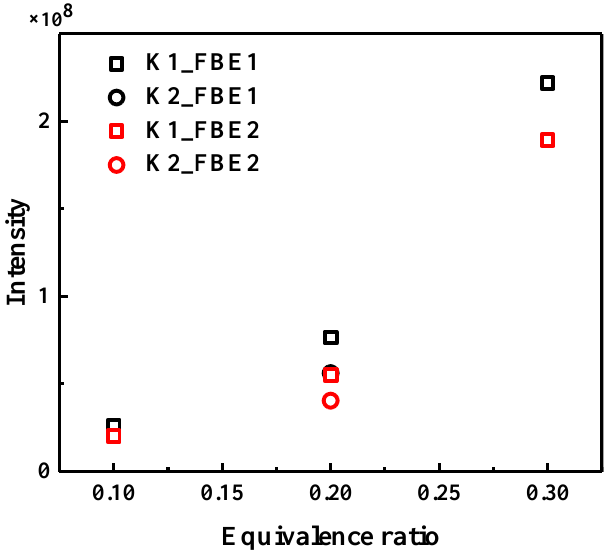
Figure 4. Overall intensity of flame chemiluminescence in different cases.